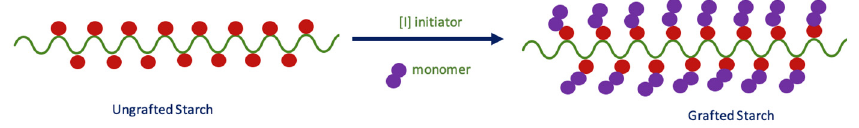
Figure 1. Schematic description of the St-g-(MA-DETA)